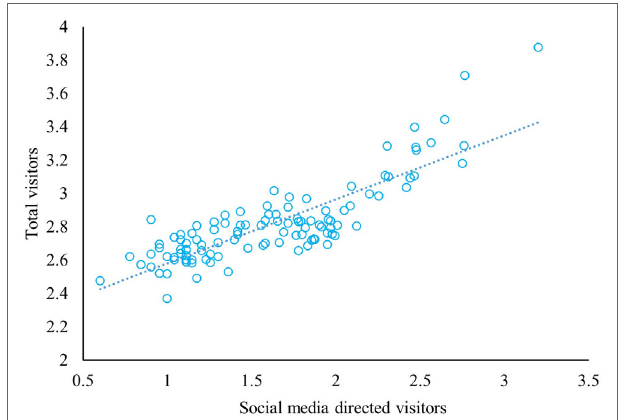
FigUre 2 | Scatter plot of social media (Log transformation).